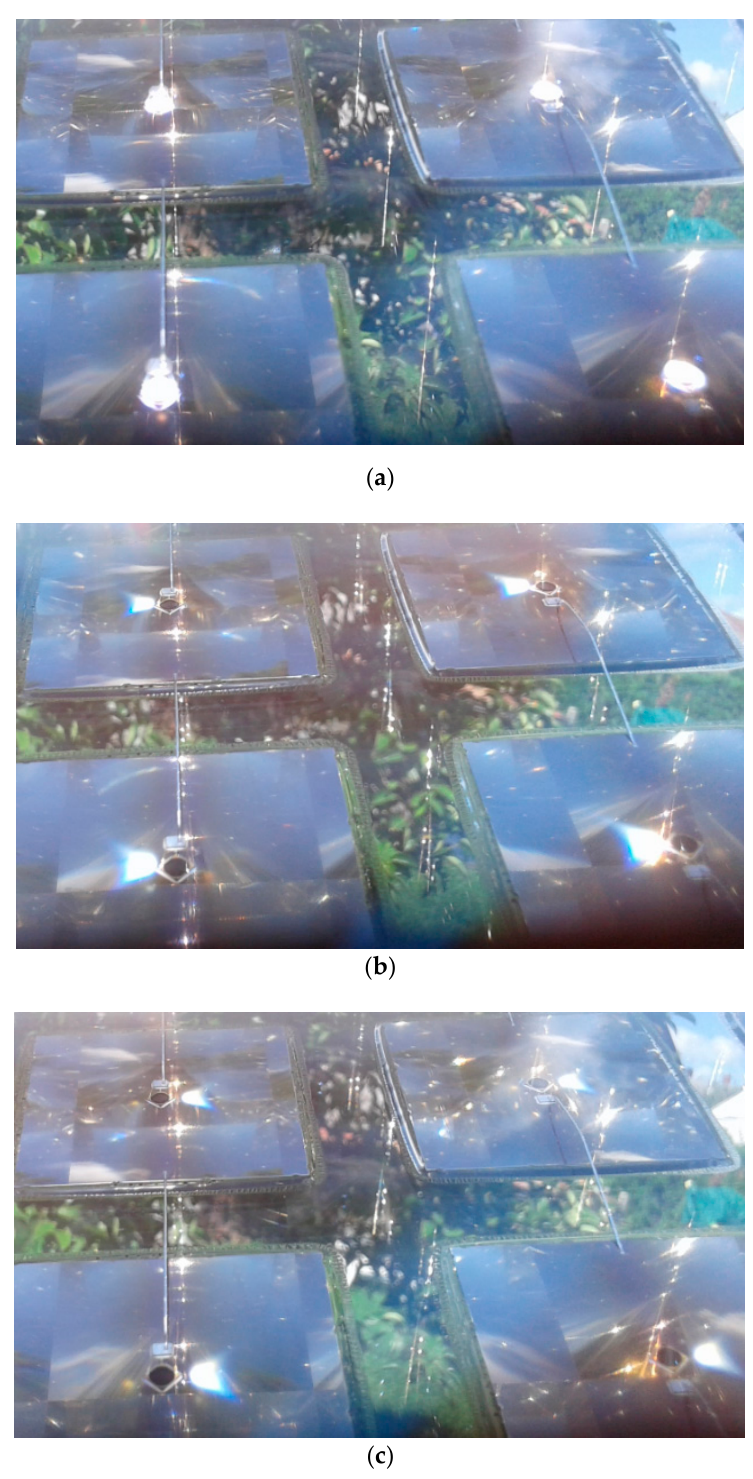
Figure 6. By using CPV cells, the inaccuracy in alignment to the sun becomes easily visible ( a ) precise setting, ( b ) inaccurate setting, ( c ) inaccurate setting.